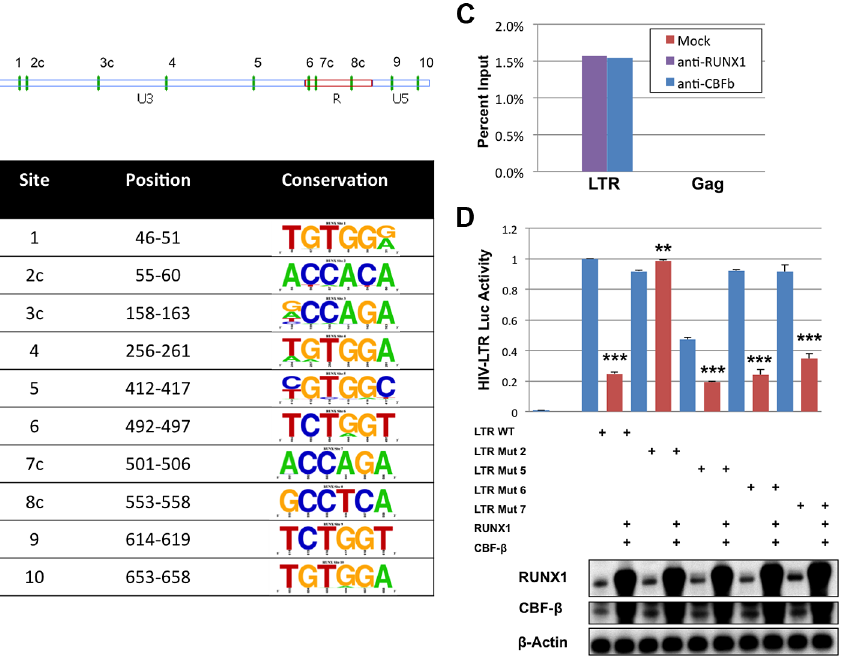
Figure 3. RUNX1 binds to the HIV-1 LTR. A ) The position of the ten predicted binding sites (green vertical dashes) represented graphically on the LTR. The letter ‘c’ following the number indicates orientation on the reverse strand. B ) The sequences corresponding to the potential binding sites were imported into UC-Berkley’s WebIcon program and used to generate graphical representations of conservation. The height of each letter in the vertical column represents the percentage of sequences that contain that base at that position. Positions where only one letter is visible represent 100% conservation within the 58 sequences examined. C ) HIV-1 infected ACH2 T-cell line was treated with 1% formaldehyde, lysed and then sonicated to shear chromatin to , 1000 bp. Sheared chromatin was incubated with antibodies against RUNX1, CBF- b or no antibody control. Antibody bound chromatin complexes were immuno-precipitated with protein A/G agarose beads and DNA was detected by qPCR against the LTR or Gag sequence. D ) 293T cells were seeded in a 6-well plate and transfected with pLTR-GL3 WT, mutant 2, mutant 5, mutant 6 or mutant 7 and RUNX1 or CBF- b vectors as indicated. Forty-eight hours after transfection the cells were harvested and cell lysates prepared. Cell extract were then used to determine the production of luciferase. Results are displayed as luciferase signal relative to transfection of the wild-type promoter construct. Western blotting was performed on transfected cells to assess the levels of RUNX1 and CBF- b expression. ** p # 0.01 and *** p # 0.001